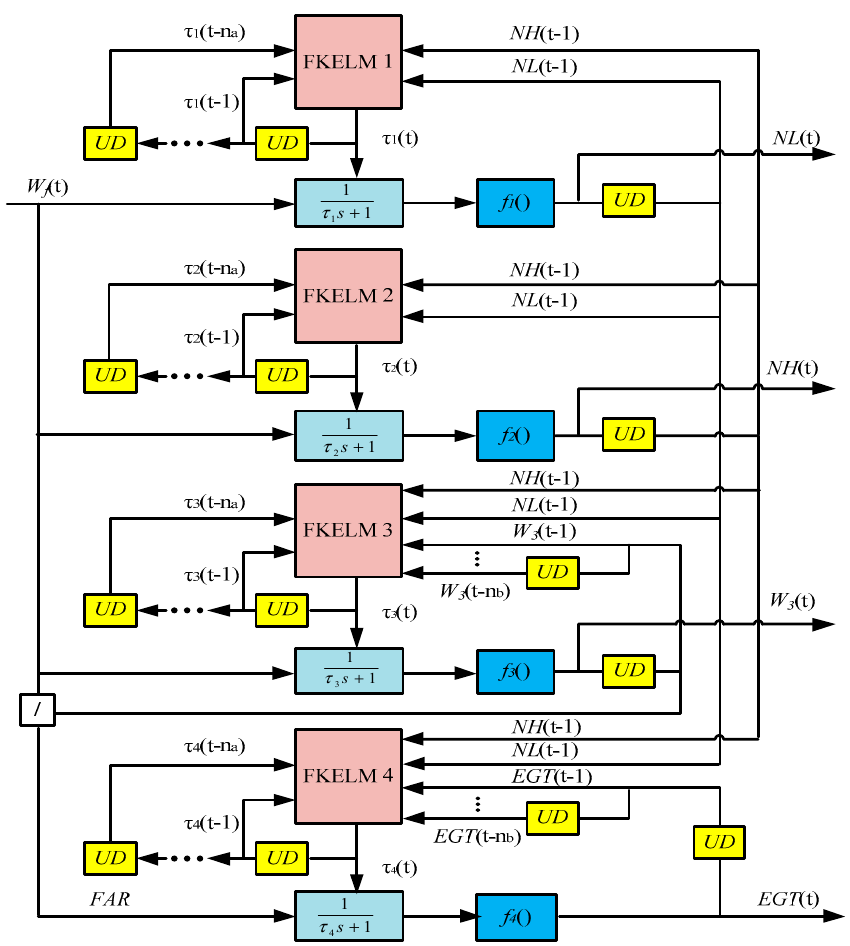
Figure 2. The bank of self-tuning Wiener models for the examined engine.